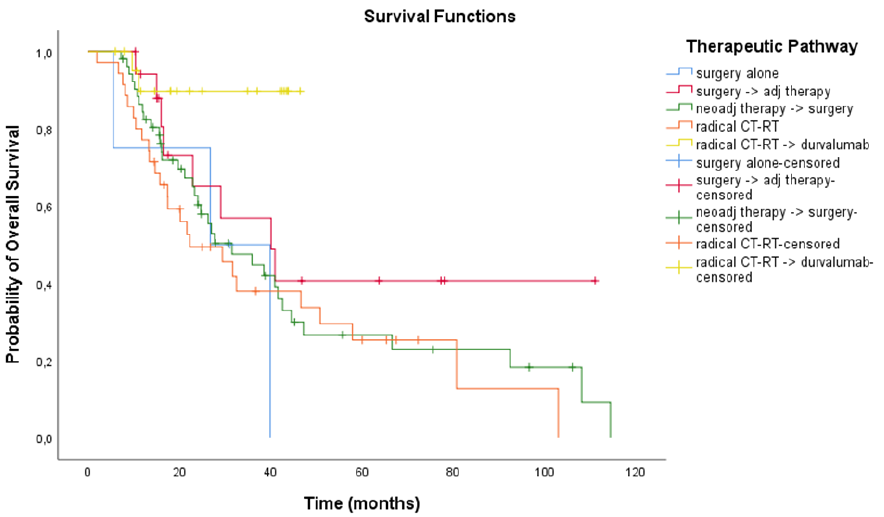
Figure 13. Kaplan–Meier curves of estimated overall survival according to treatment modality in stage IIIB-C patients. CT-RT, chemo-radiation therapy.